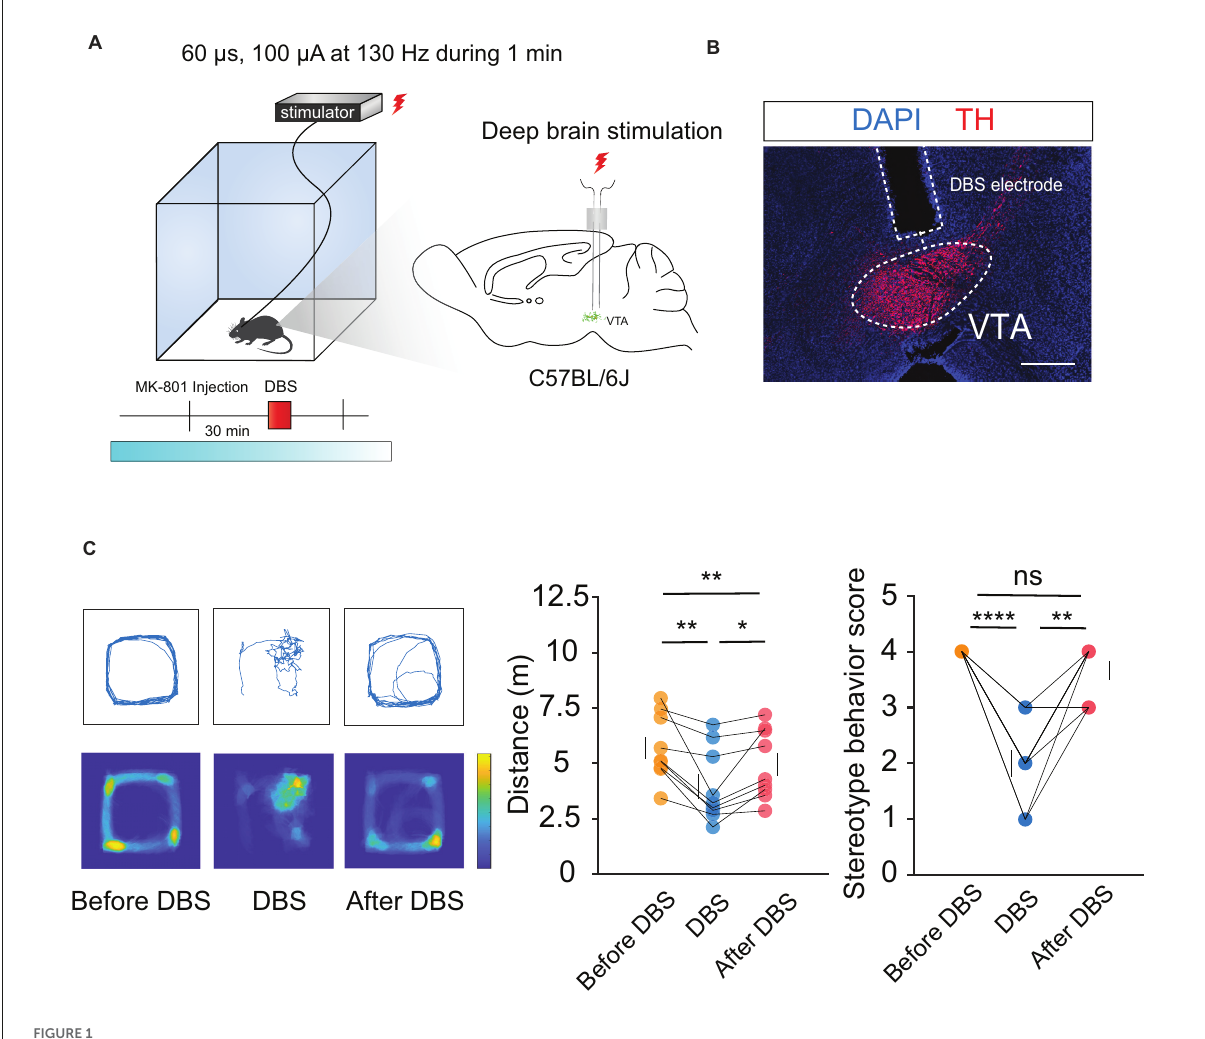
FIGURE1 DBS of the VTA alleviates hyperlocomotion and stereotyped behaviors in mice. (A) Schematic of the DBS equipment and the DBS electrode location. (B) White dashed lines indicate the location of the DBS electrode above the VTA. Scale bar, 300 µ m. TH, tyrosine hydroxylase. (C) The locomotor activity was quantified in an open field, in the presence or absence of DBS after intraperitoneal injection of MK-801. Deep brain stimulation of the VTA could decrease the hyperlocomotion and stereotyped behaviors caused by the MK-801 injection. * p < 0.05, ** p < 0.01, **** p < 0.0001, ns: no significance. One-way ANOVA. All error bars represent ± SEM. N = 9 mice.